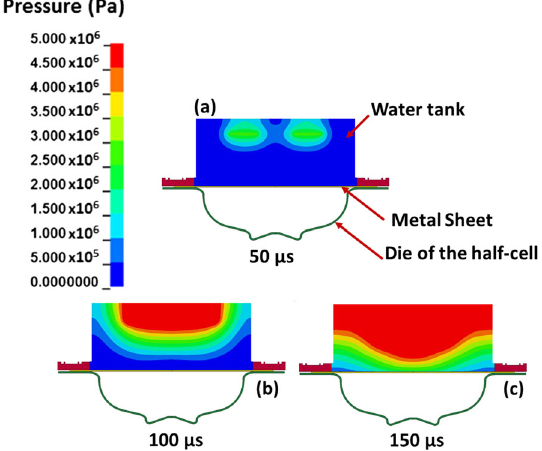
FIG. 5. Pressure evolution inside the water tank after the electrical discharge between the electrodes: after 50 μ s from